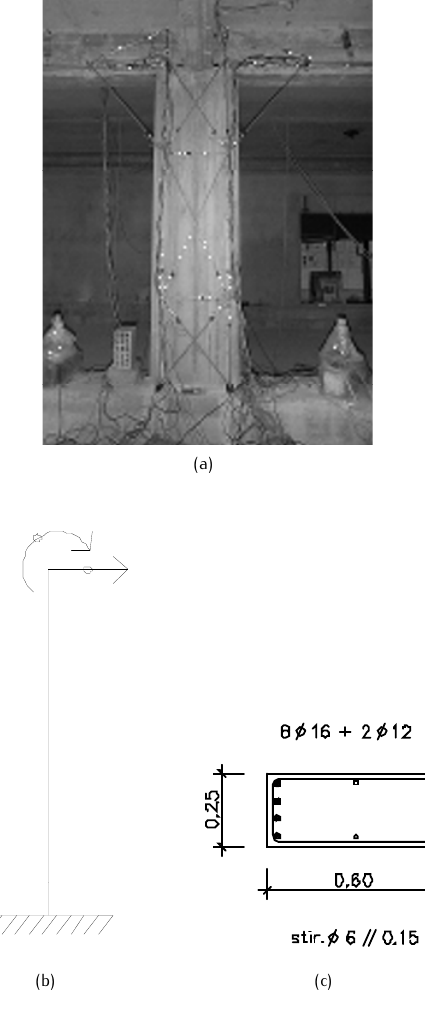
Figure 9. Studied column: a) The storey instrumentation; b) Model studied; c) Column reinforcement